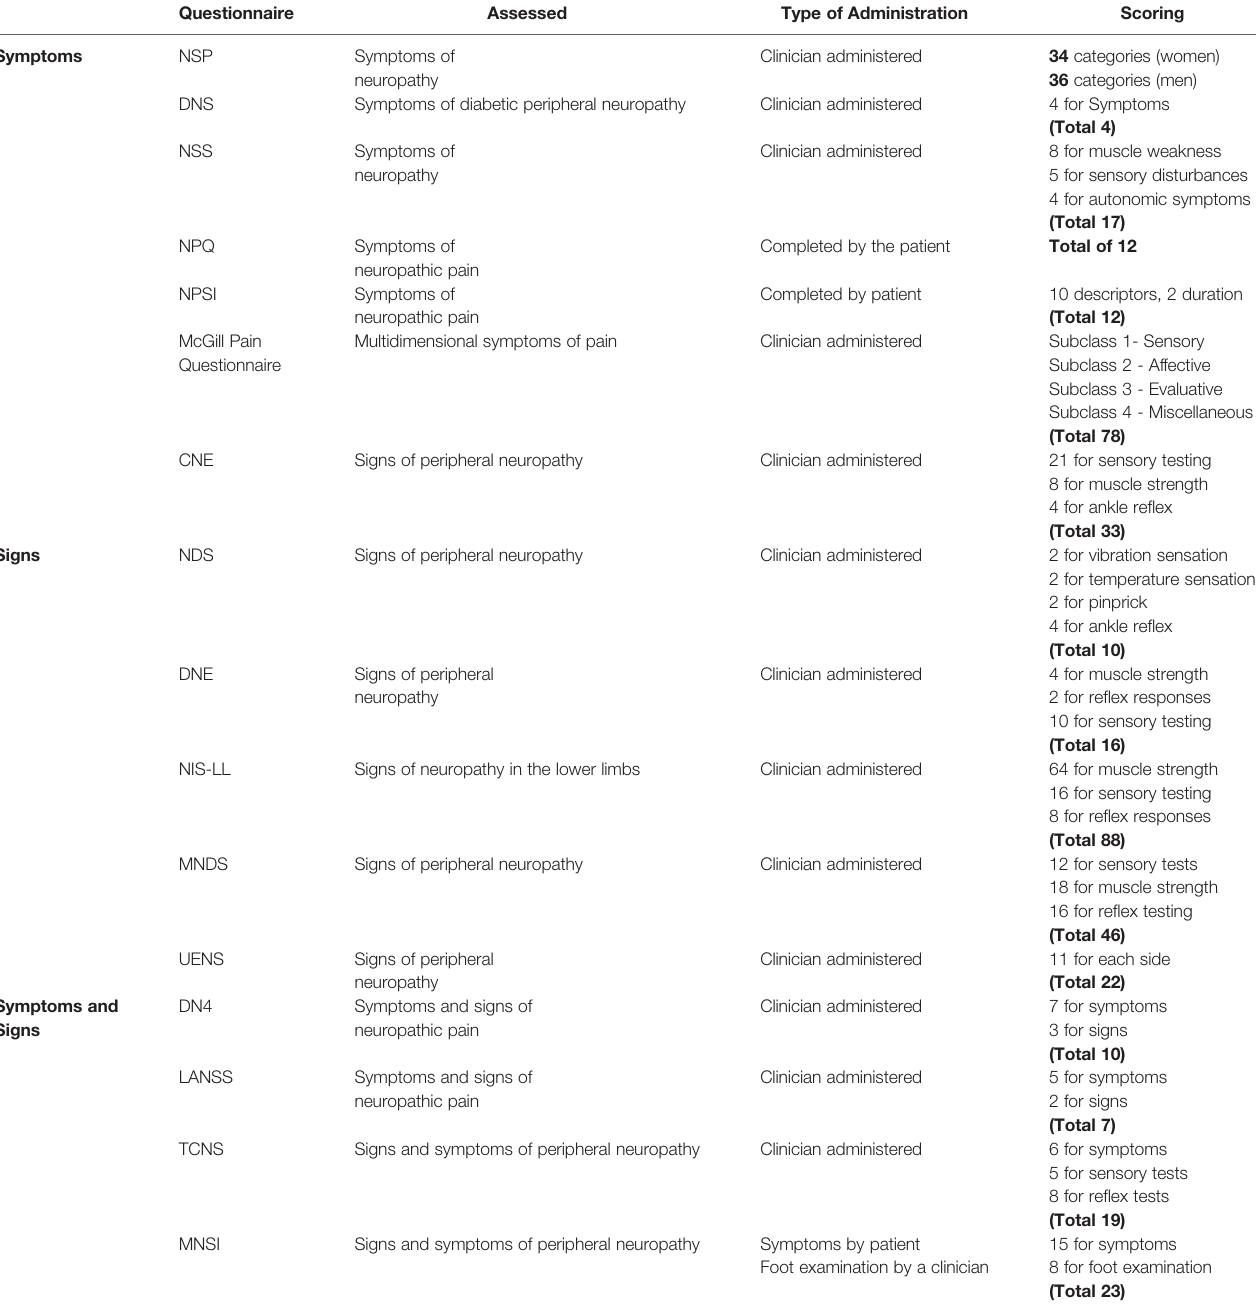
TABLE 3 | Summary of questionnaires available for assessing